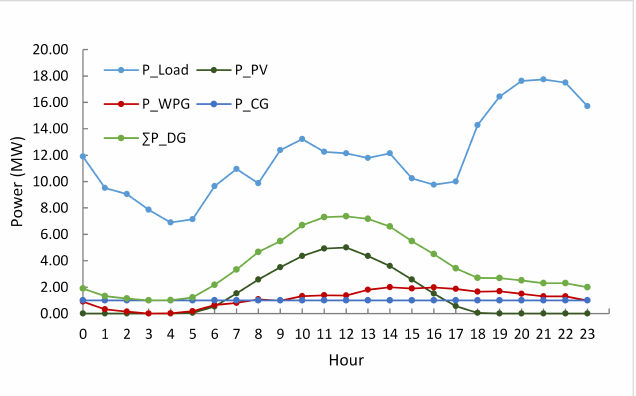
Figure 11. Active power for 141-bus system: PV, WPG, CG, load curve, and DG